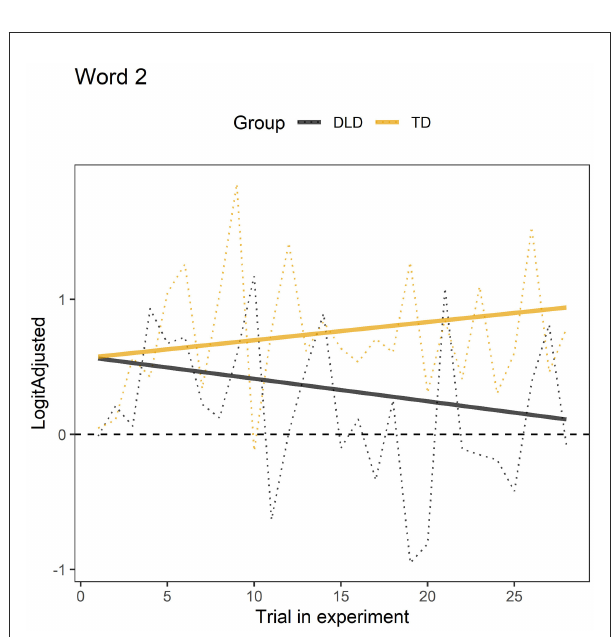
FIGURE8 Graph depicting looks towards the target picture per Group and Trial for Word2. The dotted line represents the actual data, the solid line represents the prediction of the statistical